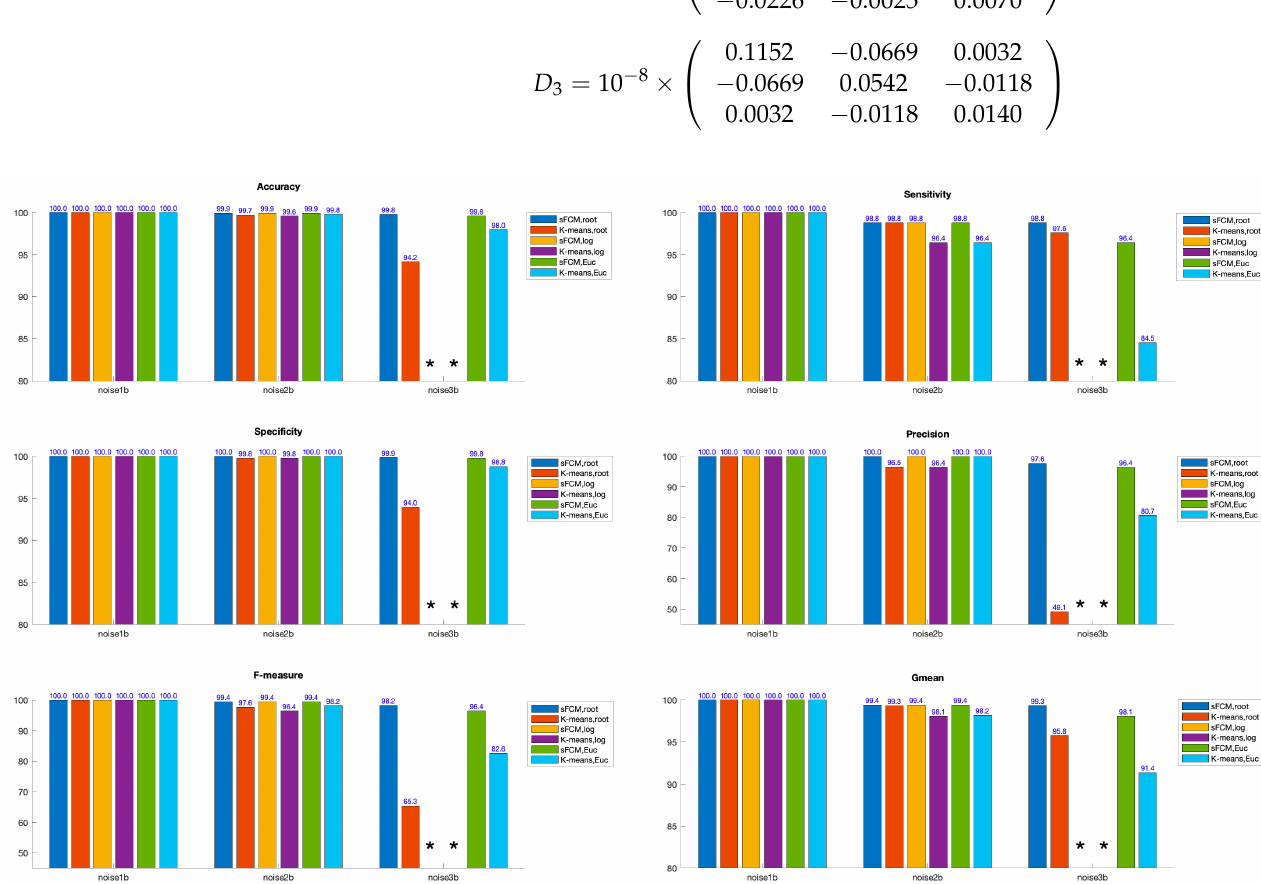
Figure 6. Bar charts of the performance measures. Root Euclidean using sFCM generally yields the highest values of performance measures. Using log Euclidean, the CC is not even detectable at noise level 3b (denoted here by a *). To enable better visualisation of the results, a scale of 45–100 for precision and F-measure and 80–100 for the rest of the measures is